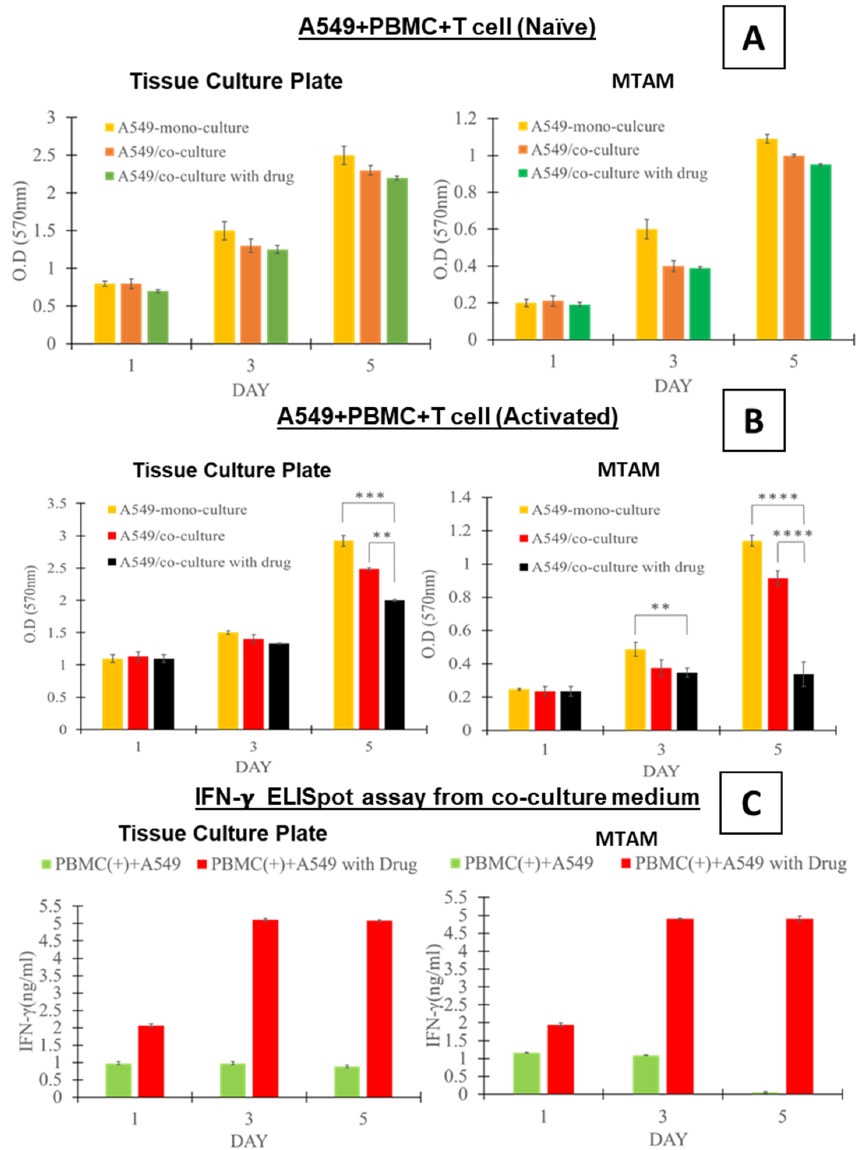
Figure 2. ( A ) In vitro comparison of A549 monoculture, A549 co-culture with PBMCs and A549 co- culture with PBMCs and anti-PD1 drug on day 1, 3 and 5 utilizing TCPs and PSF MTAMs. ( B ) Culture of A549 monoculture, A549 co-culture with PBMCs and A549 co-culture with PBMCs and anti-PD1 drug with the activation of T cells. ( C ) ElisaSpot assay of interferon gamma of the co-cultured cells in TCP and MTAMs. ** equivalent to p -value < 0.01; *** equivalent to p -value < 0.001; **** equivalent to p -value <